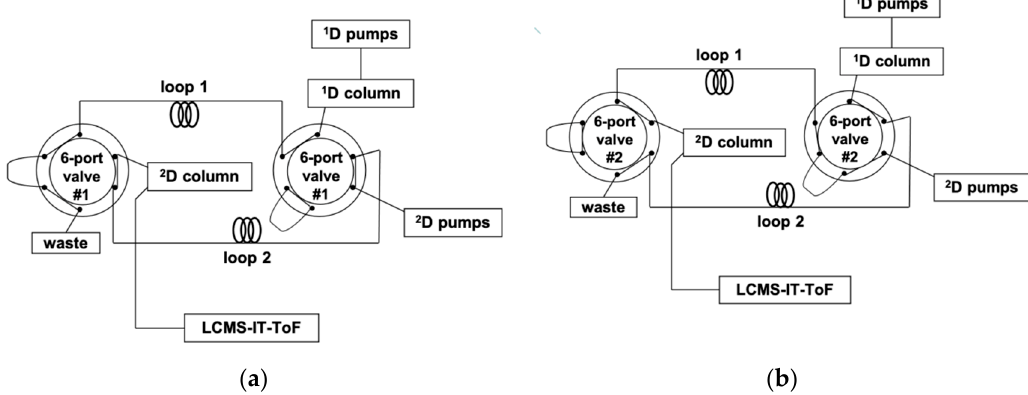
Figure 1. Schematic of the LC × LC system, showing the routes for each 2 D separation, corresponding to different positions of the two six-port, two-position switching valves. ( a ) Loop 1 becomes filled with the 1 D eluent, while the 2 D pumps flush the content of loop 2 towards the 2 D column. ( b ) Loop 2 becomes filled with the 1 D eluent, while the 2 D pumps flush the content of loop 1 towards the 2 D